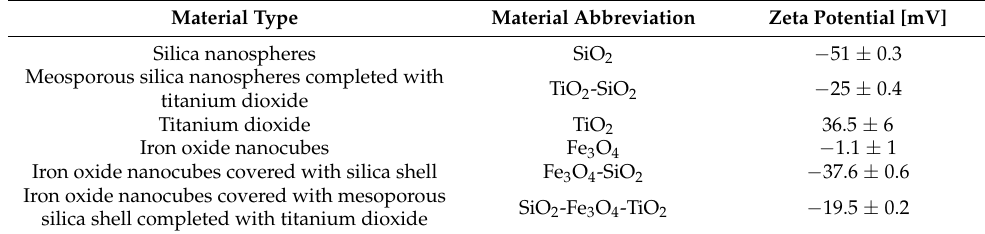
Table 1. Characteristics of the tested nanoparticles.